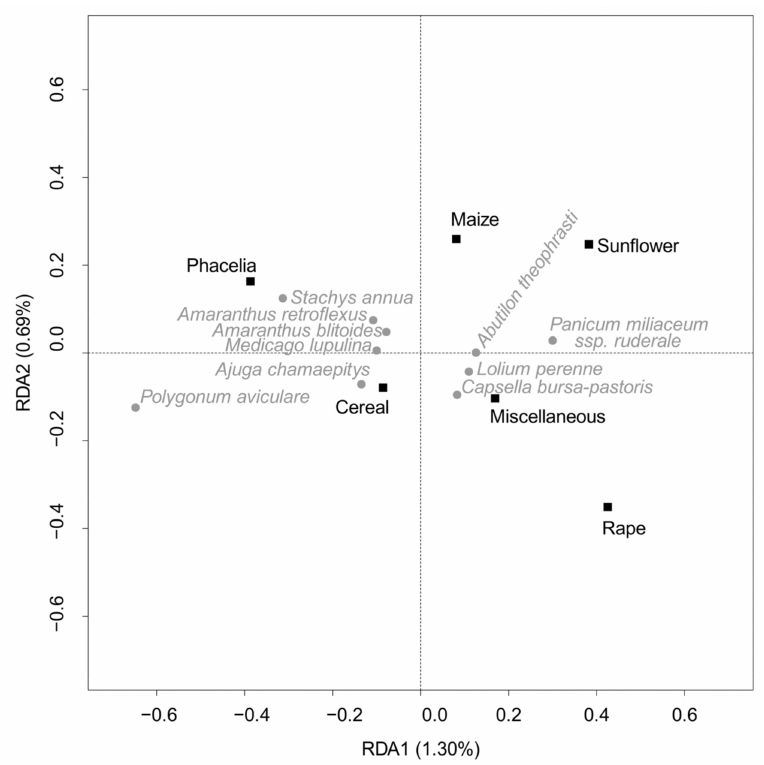
Figure 3. Ordination diagram of the partial RDA model containing the explanatory variable preceding crop in the broad-scale survey (BS). The 10 species with the highest weight on the first two RDA axes are presented. Note that only the first axis is significant at the 2%